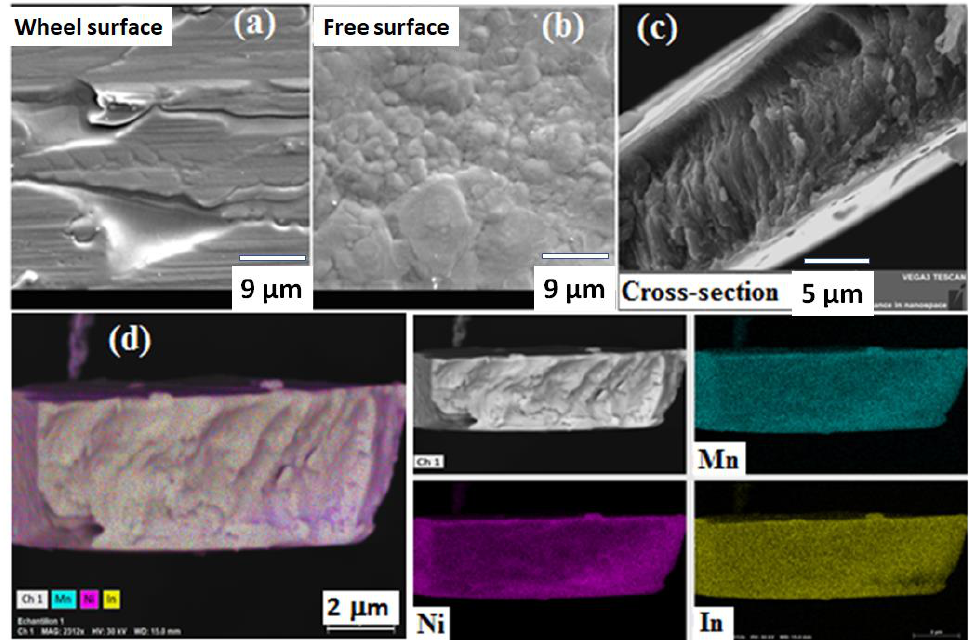
Figure 1. Typical SEM micrographs of wheel surface ( a ), free surface ( b ), fracture cross-section ( c ), and ( d ) EDS element-mapping of Ni 51.82 Mn 32.37 In 15.81 ribbons. Rietveld refinement of the XRD pattern of the melt-spun ribbons (Figure 2) reveals the coexistence of a seven-layered monoclinic 14 M structure, P 2/ m space group, with lattice parameters a = ( 4.3381 ± 0.0002 ) Å, b = ( 5.5642 ± 0.0002 ) Å and c = ( 29.235 ± 0.0005 ) Å and β = 92.92 ◦ , and a cubic B 2 austenite structure, space group Pm 3 m , and a lattice parameter of a = ( 2.9684 ± 0.0002 ) Å. The relative deviations of the lattice parameters ( a − a 0 ) ( b − b 0 ) ( c − c 0 ) shown by: ∆ a = , ∆ b = , and ∆ c = where a 0 , b 0 and c 0 are the lattice a 0 c 0 b 0 parameters of a perfect crystal, reaching as much as ∆ a = 0.88%, ∆ b = − 3.6% and ∆ c = 0.81% for the 14M structure, and ∆ a = − 1.6% for the B2 austenite. In addition, the weight fractions of both the 14M martensite and B2 austenite structures are equal to 50%, and